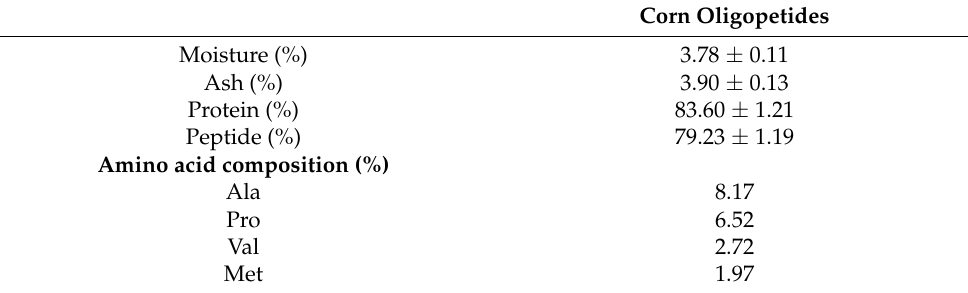
Table 2. Chemical composition of